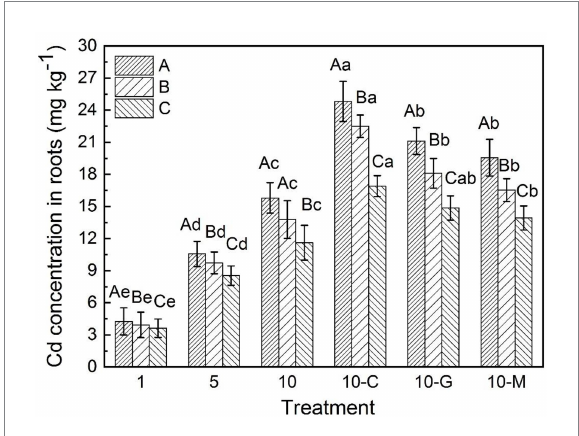
FIGURE 1 Cadmium concentration in roots of Sorghum sudanense under different soil types. The values shown are the mean ± SE ( n = 3). Differences sampled indicated by capital letter are between soil types, and by lower-case letter are Cd/exudates related. The same letters among specific treatments are not significantly different according to Duncan’s (0.05). A, B, and C represent sandy, loamy, and clayey, respectivly. Treatments: 1, 1 mg kg − 1 cadmium ion-contaminated soil; 5, 5 mg kg − 1 cadmium ion- contaminated soil; 10, 10 mg kg − 1 cadmium ion-contaminated soil; 10-C, 10 mg kg − 1 cadmium ion-contaminated soil with the addition of 20 ml citric acid solution at 50 mmol L − 1 ; 10-G, 10 mg kg − 1 cadmium ion-contaminated soil with the addition of 20 ml glycine solution at 50 mmol L − 1 ; 10-M, 10 mg kg − 1